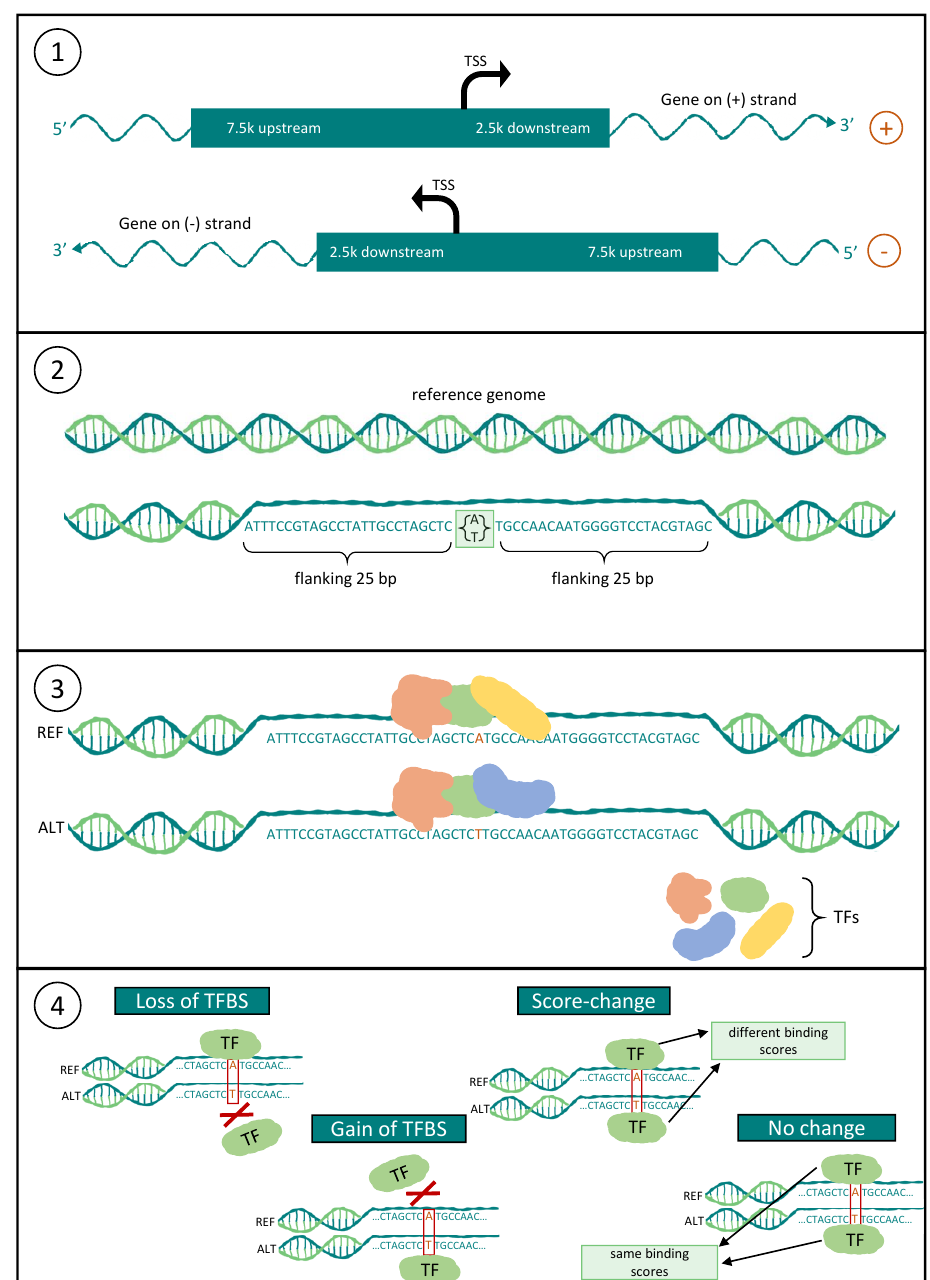
Figure 2. Scheme of the workflow applied for the detection of rSNPs. ( 1 ) Definition of the promoter region as 7.5 kb upstream (5 (cid:48) direction) and 2.5 kb downstream (3 (cid:48) direction) of the TSS, and extraction of SNPs within this region; ( 2 ) extraction of the flanking 25 bp around the SNPs from the reference genome; ( 3 ) prediction of the TFBSs for both the reference and alternate sequences; and ( 4 ) deriving the consequences for each SNP-TFBS